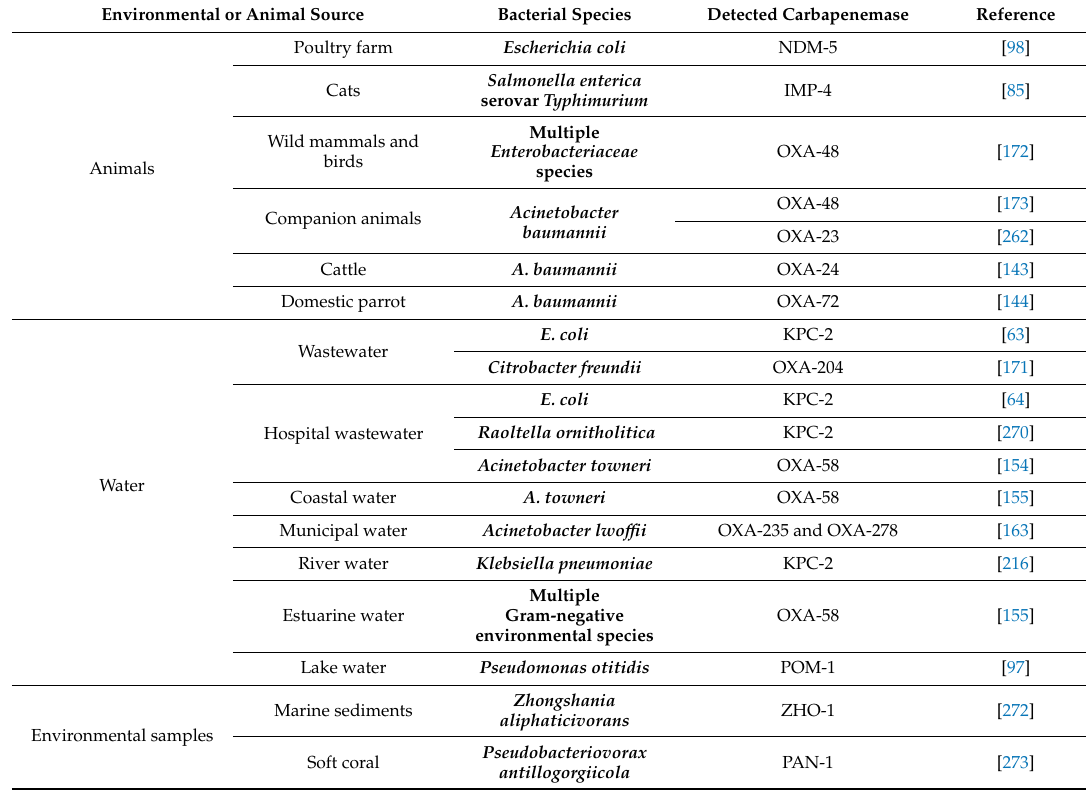
Table 2. Examples of carbapenemases detected in Gram-negative bacteria from animal and environmental